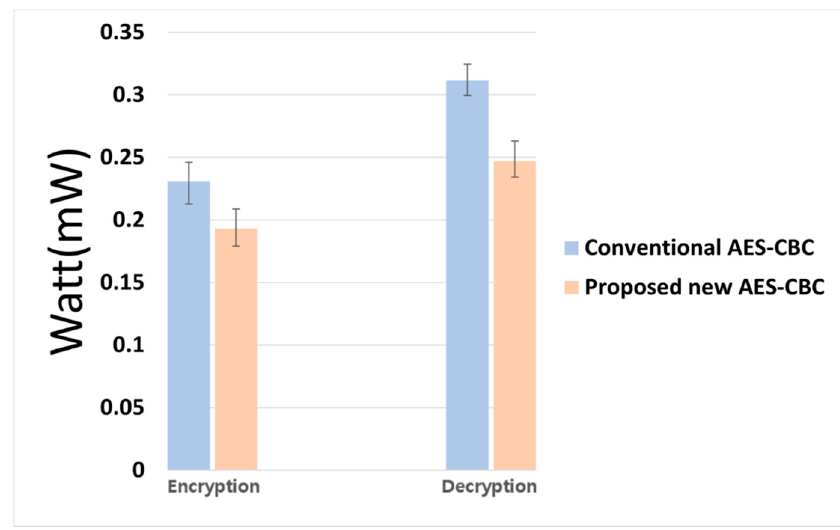
Figure 16. Average power consumption during encryption and decryption in conventional AES-CBC and proposed AES-CBC algorithms. Table 7. Average power consumption and standard deviation during encryption and decryption.